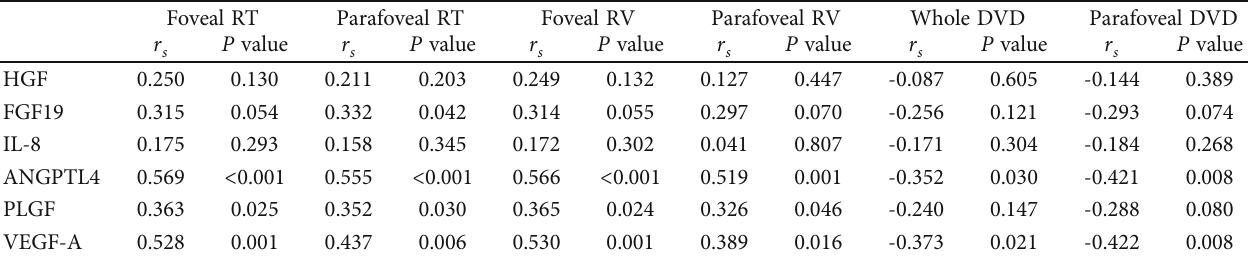
Table 4: Correlation between cytokine levels in aqueous humor and OCTA metrics in NPDR eyes ( n = 38